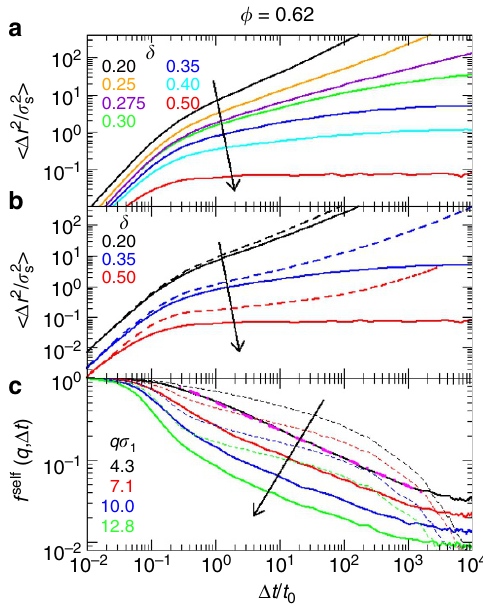
Figure 5 | Small particle dynamics in a mobile or immobile large particles matrix. ( a ) MSDs of the small particles for immobile large particles at f ¼ 0.62 and various values of d , as indicated. For d imm c (cid:4) 0 : 275 a clear subdiffusive behavior is observed at all times. ( b ) Comparison of the MSDs of the small particles at f ¼ 0.62 for mobile (dashed lines) and immobile (full lines) large particles, for increasing d , as indicated. ( c ) Self intermediate scattering functions f self ( q , D t ) at f ¼ 0.62 and different wavevectors q s l , as indicated, for d ¼ 0.25 (immobile, full lines) and d ¼ 0.35 (mobile, dashed lines) highlighting the power-law dependence (dot-dashed line) in the immobile case. Arrows indicate increasing D or increasing q